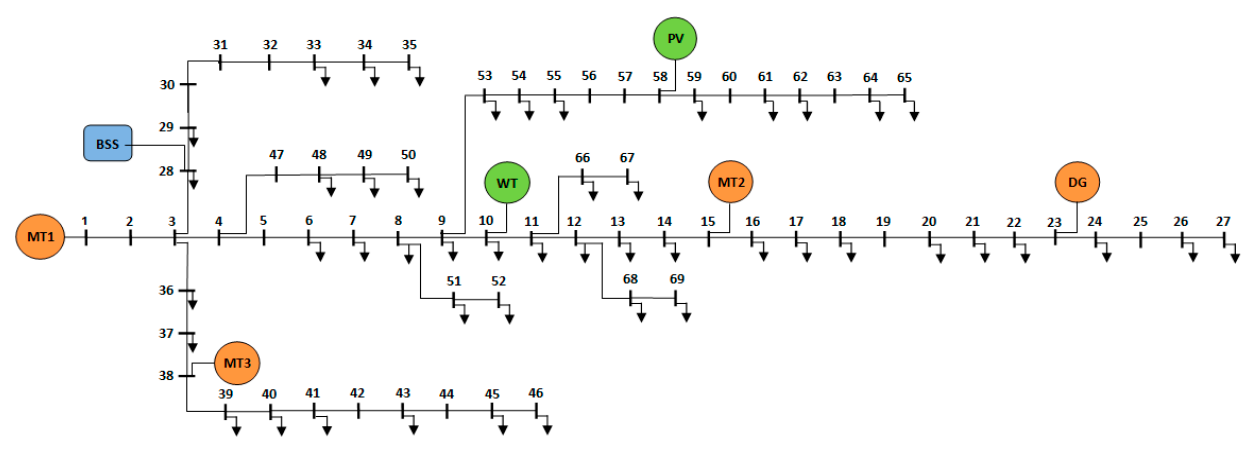
Figure 9. Larger microgrid network: modified IEEE 69-node test feeder.